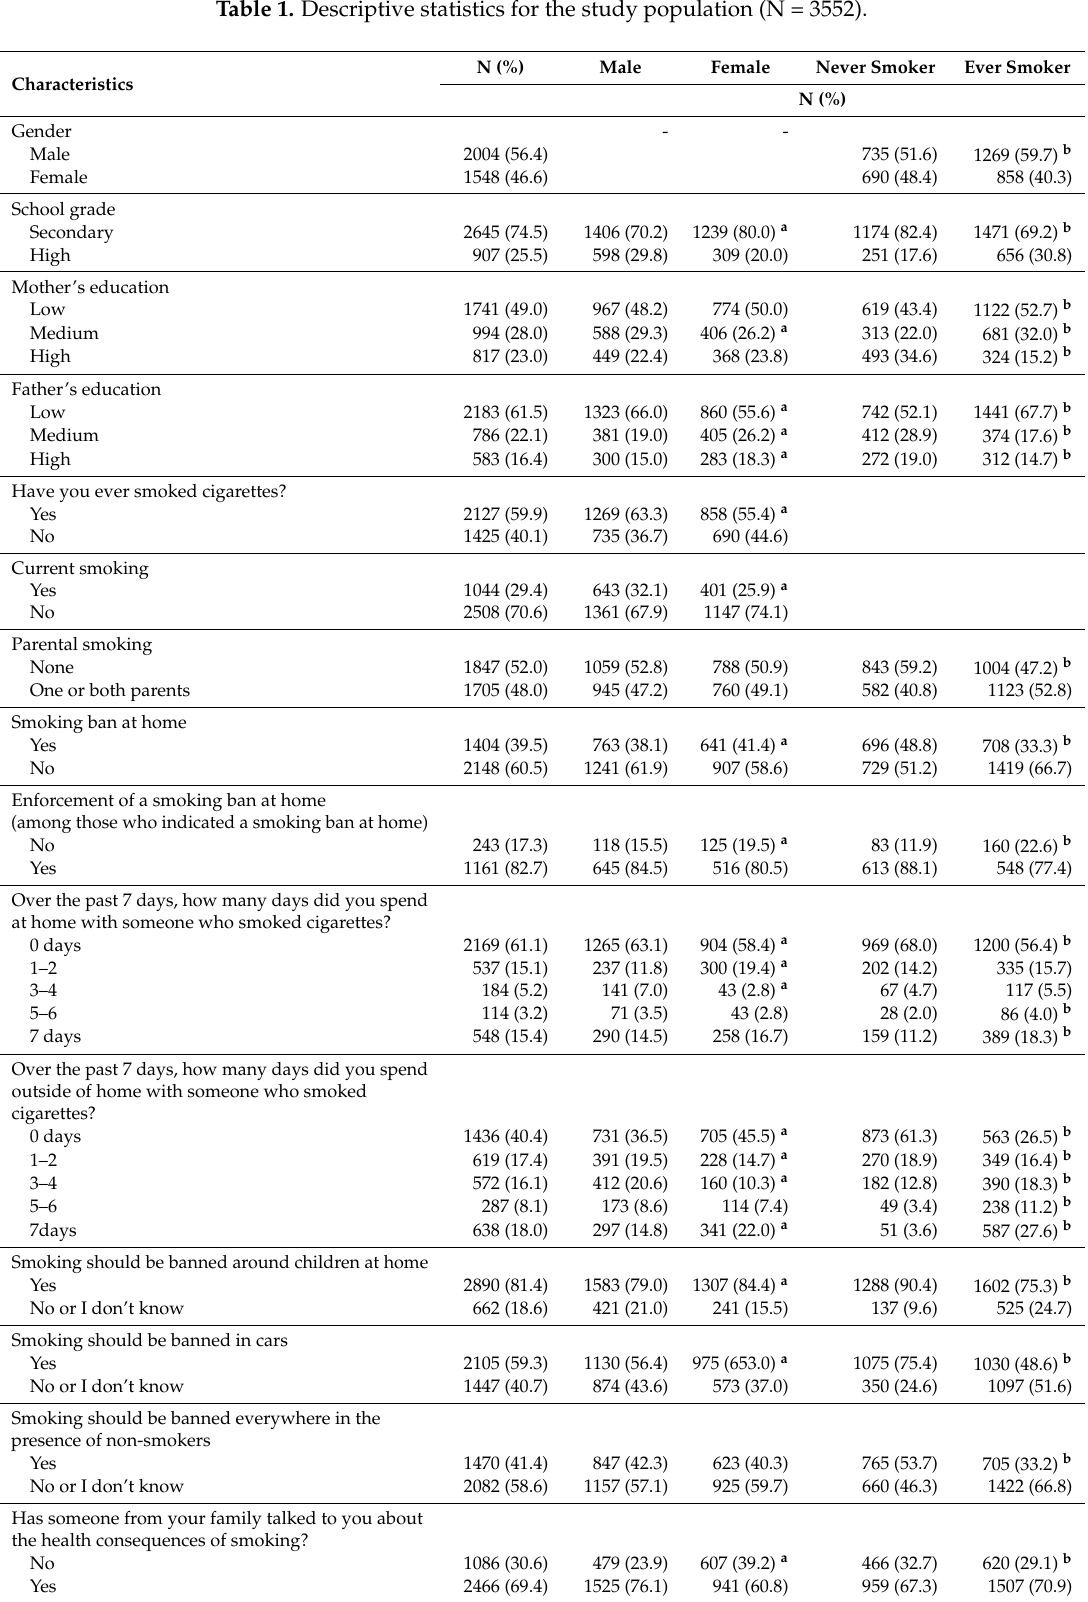
Table 1. Descriptive statistics for the study population (N =